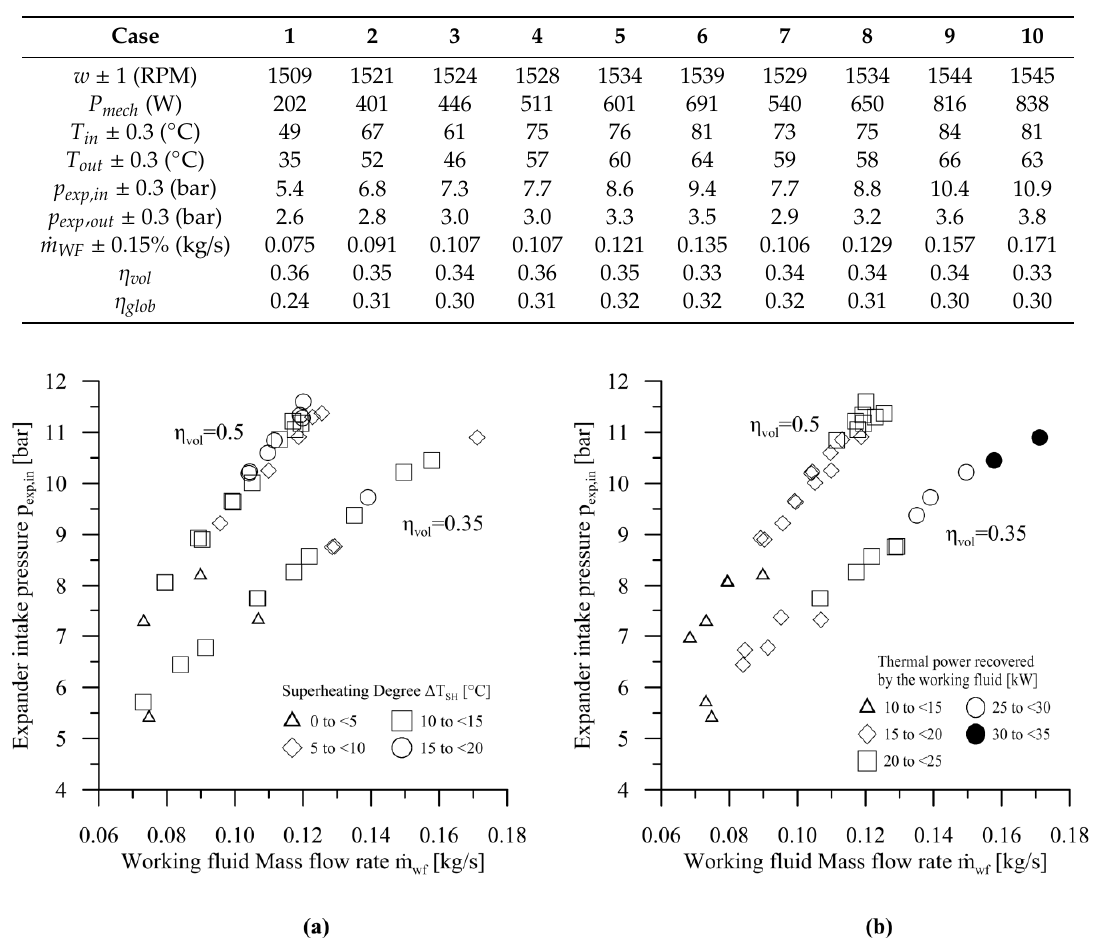
Table 5. Experimental characterization of the expander with η vol = 0.35.